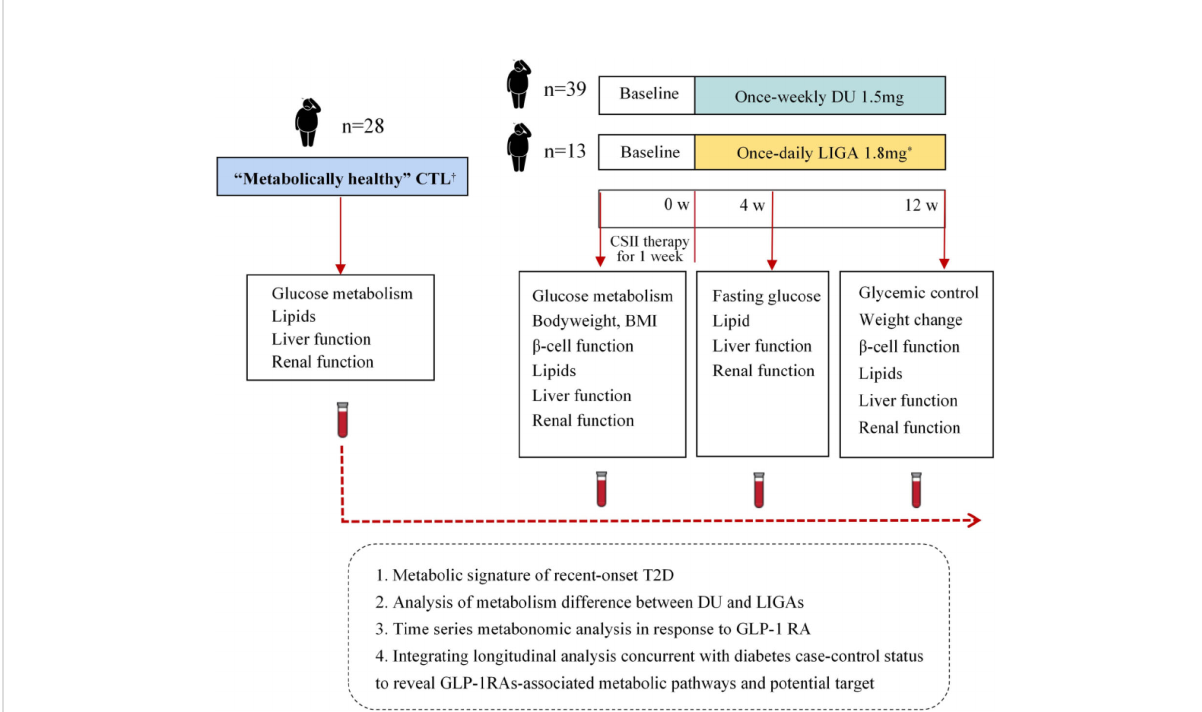
FIGURE 2 Study design and comparative analysis of metabolic pro fi les. *Liraglutide was up titrated from 0.6 mg/day in the fi rst week, to 1.2 mg/day in the second week, and then to 1.8 mg/day in the third week. † Criteria for “ metabolically healthy ” are as follows: no previous history of high blood pressure and systolic blood pressure (SBP)/diastolic blood pressure (DBP) < 140/90 mmHg; no previous history of diabetes and fasting blood glucose (FBG) < 6.1 mmol/L, OGTT (2 h) < 7.8 mmol/L and; no previous history of high cholesterol (total cholesterol (TC) < 5.18 mmol/L) and fasting plasma TG < 1.7 mmol/L and fasting serum high-density lipoproteincholesterol (HDL-c) ≥ 0.9 mmol/L (men) or ≥ 1.0 mmol/L (women); no history of cardiovascular or endocrine disease. DU, dulaglutide; LIGA, liraglutide; CTL: control; CSII, continuous-subcutaneous insulin infusion; BMI, body mass index; CGMS, continuous glucose monitoring system; GLP-1 RA, glucagon-like peptide-1 receptor